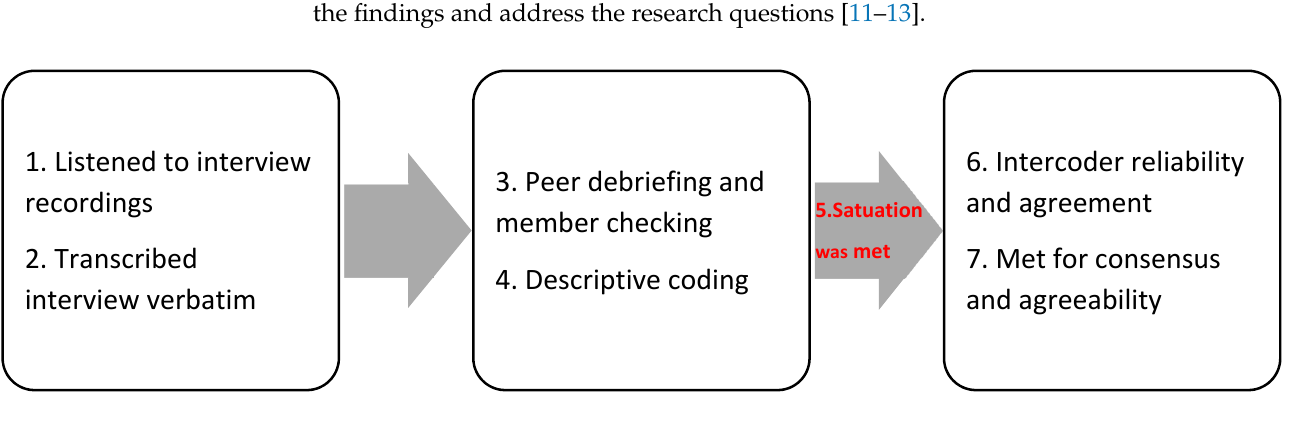
Table 4. Defined Criteria to Report INnovations in Education (DoCTRINE).